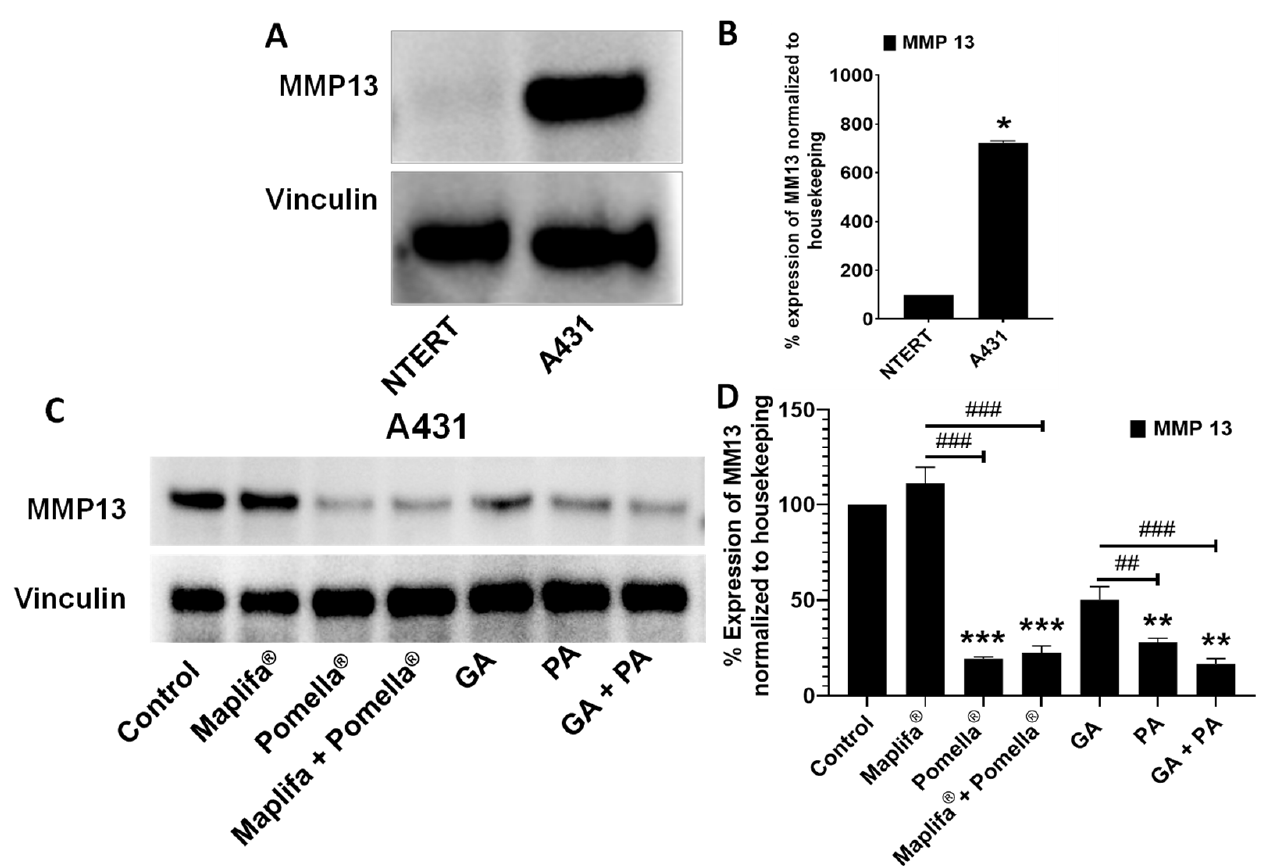
Figure 6. Protein expression levels of metalloproteinase 13 (MMP-13) on NTERT and A431 whole cell lysates without any treatment ( A ) and significant increase of MMP-13 expression in A431 compared to NTERT ( B ). Measurement of MMP13 expression on A431 upon treatment with Pomella ® and Maplifa ® extracts (both at 12.5 µ g/mL), their pure compounds PA and GA (both at 12.5 µ M) and their 1:1 combination each at 12.5 µ M. The inhibitory effects were determined by the Western blot assay using A431 cell lysates ( C ). Data are expressed as means ± standard deviation (S.D.) from three independent experiments performed in duplicate ( B , D ). Statistically significant difference was considered * p < 0.05, ** p < 0.01, *** p < 0.001 when compared to the control group and ## p < 0.01, ### p < 0.001 when compared between individual treatment groups.